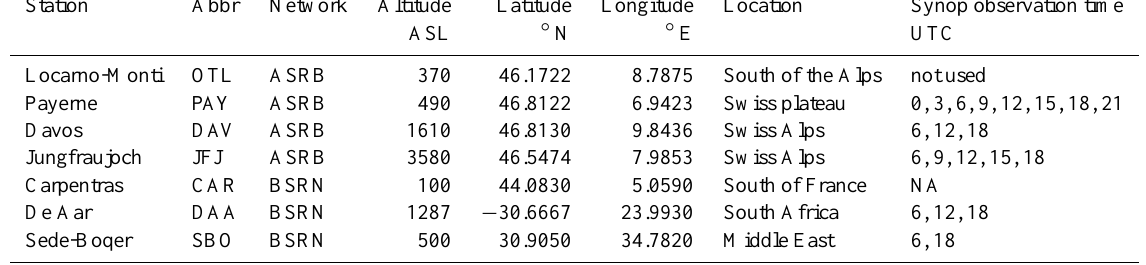
Table 1. Surface radiation sites for the development (OTL, PAY) of HelioFTH and the validation (except OTL) of satellite cloud products. Station